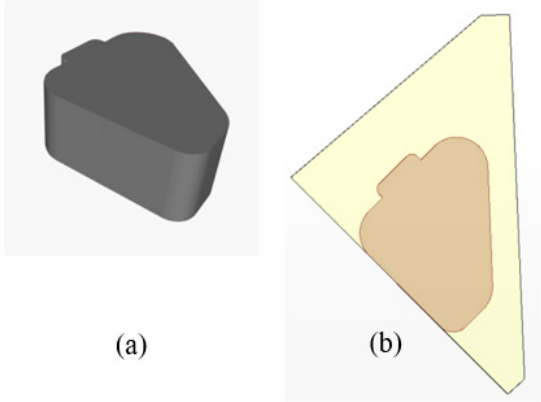
Figure 12. ( a ) LOD 1 CityGML 3.0 ADE model and ( b ) the building (brown) located in the area in the development plan where it will be placed according to the building permit application.